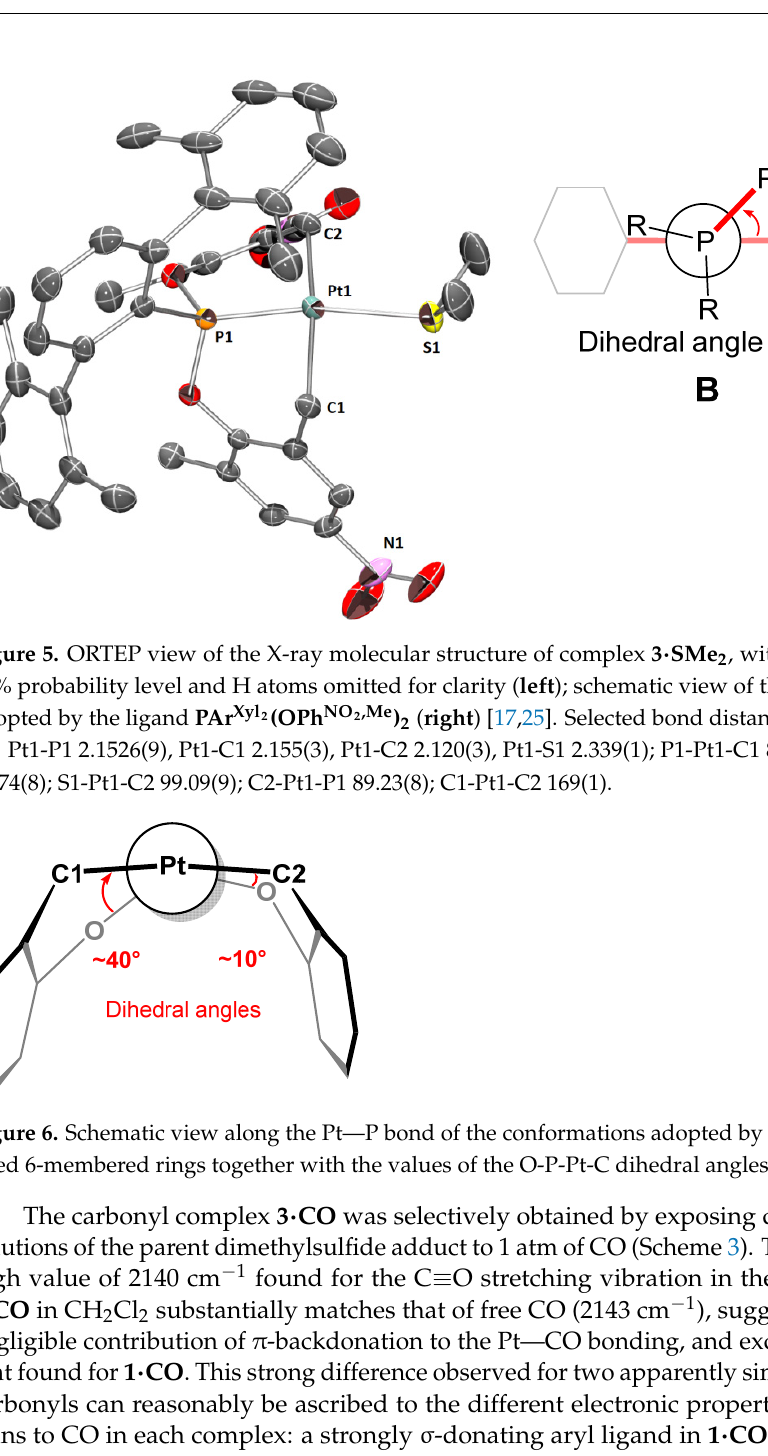
Figure 6. Schematic view along the Pt—P bond of the conformations adopted by the two cyclomet- alated 6-membered rings together with the values of the O-P-Pt-C dihedral angles. The carbonyl complex 3 ∙ CO was selectively obtained by exposing dichloromethane solutions of the parent dimethylsulfide adduct to 1 atm of CO (Scheme 3). The unexpect- edly high value of 2140 cm − 1 found for the C ≡ O stretching vibration in the IR spectrum of